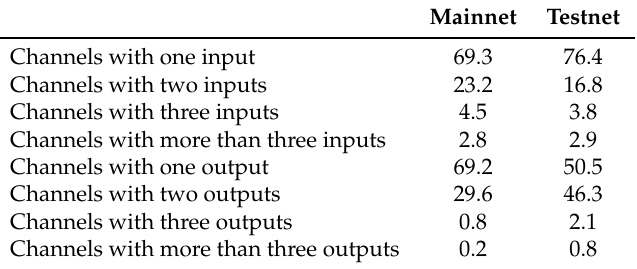
Table 2. Percentages of input-output count for